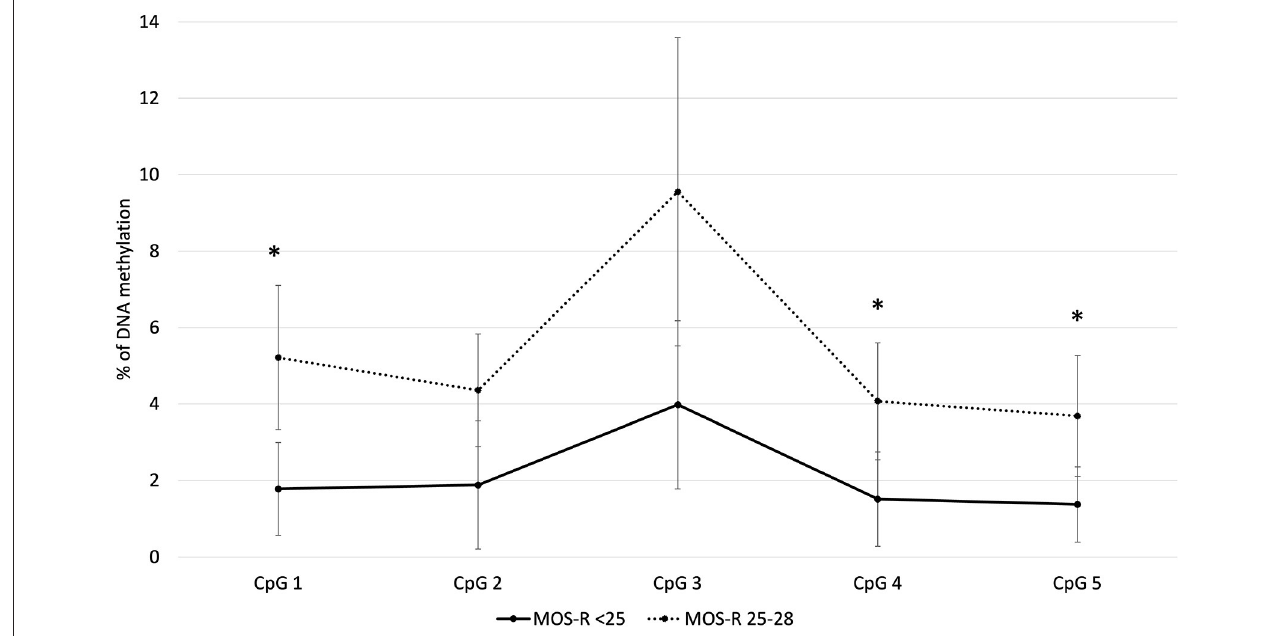
FIGURE 1 | Average methylation for the NR3C1 gene individual CpG sites. * p < 0.05. MOS-R, Motor Optimality